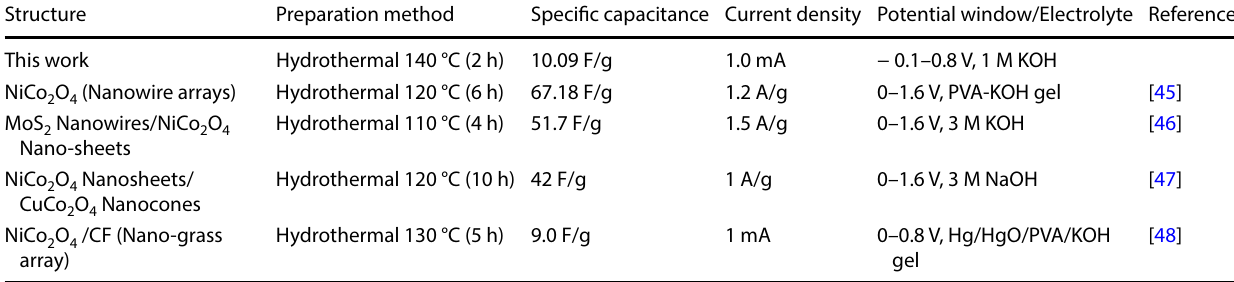
O -based composites 2 4